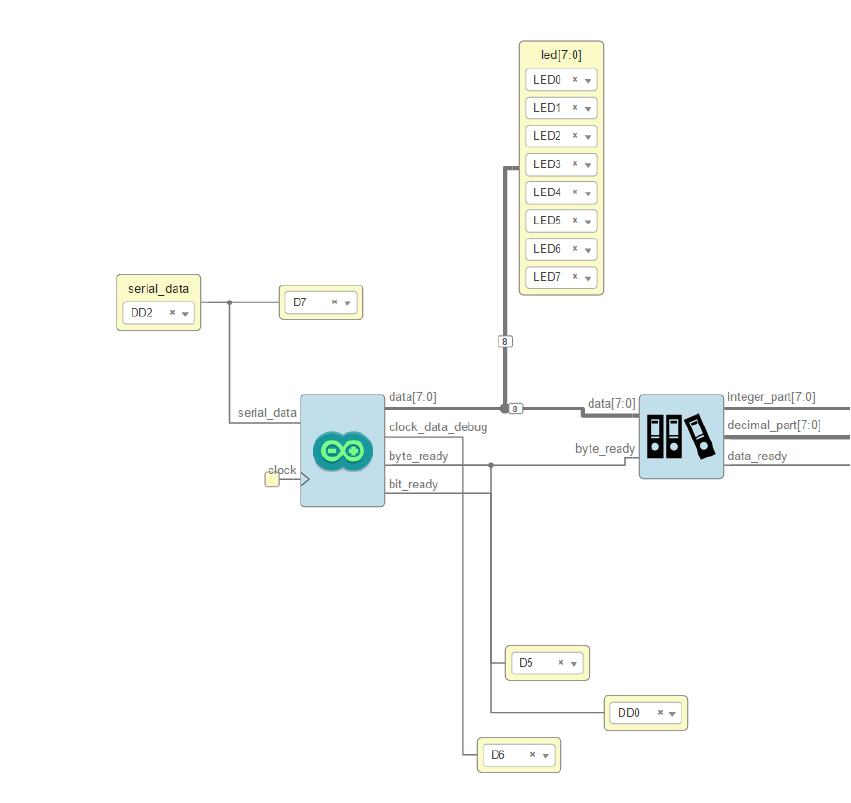
Figure 9. Communication between Arduino and IceZum Alhambra.